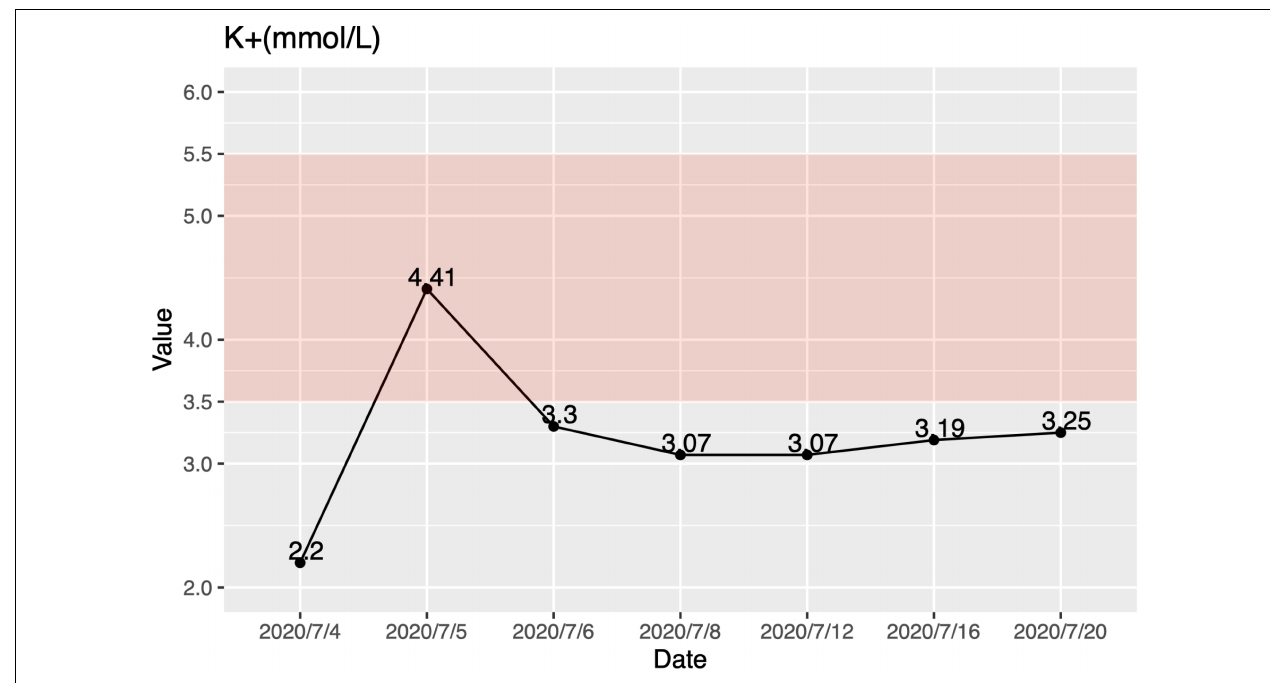
FIGURE 1 | Hypokalemia in this patient. The lowest serum potassium was 2.2 mmol/L. Oral potassium supplementation (100 g potassium citrate mixed with 1,000 ml water, 5 ml PO. Tid.) could not keep her blood potassium at normal levels. The pink area is the normal range.